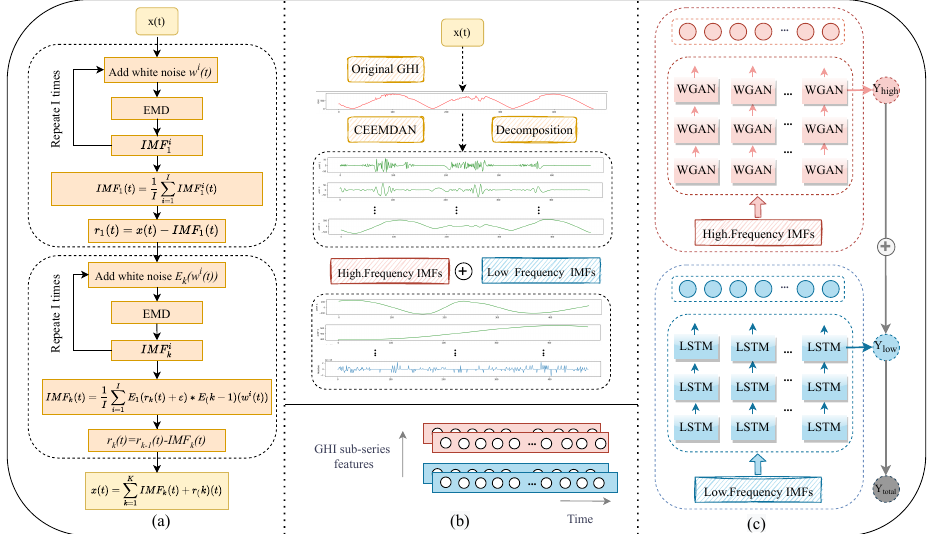
Figure 1. The proposed CEE-W-L overall framework flow chart. ( a ) Flow chart of the signal de- composition module. ( b ) High- and low-frequency characteristic arrangement of GHI data after decomposition. ( c ) Detailed diagram of two-channel neural network